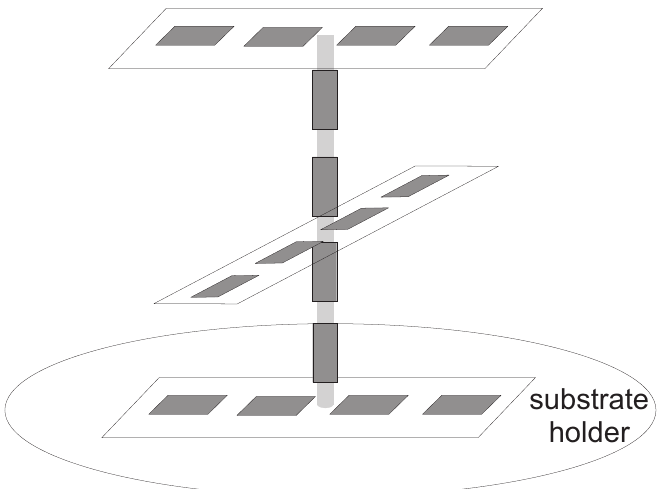
Figure 5. Device for controlling the spatial deposition rate across the reactor. Each of the four carrier plates hosts four microscope slides. At each trial, only one arm is subjected to